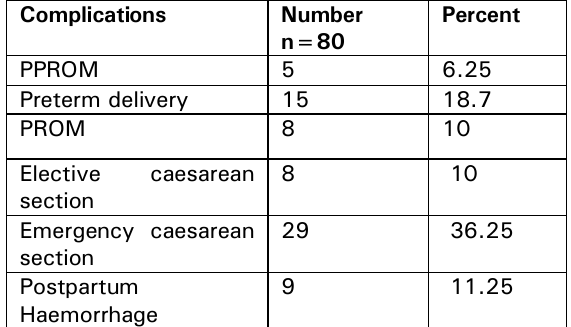
Table 4 : Complications of pregnancy